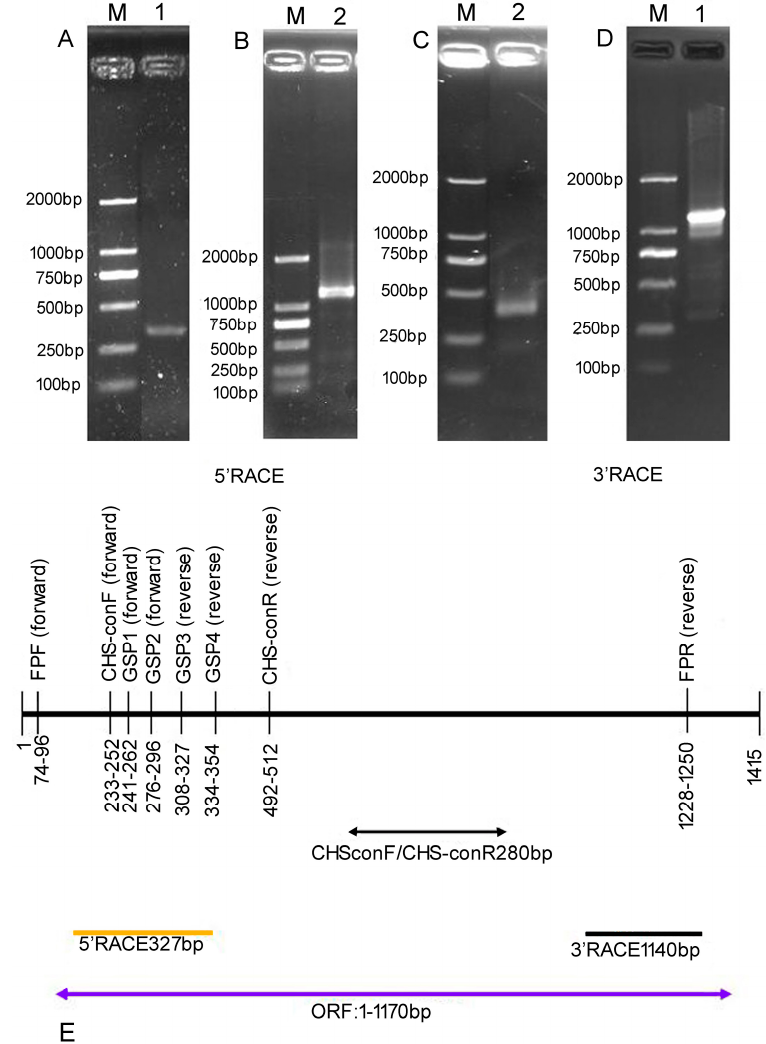
Figure 2. Isolation and identification of BaCHS . ( A ) RT-PCR products from the petals of Brunfelsia acuminata with primers CHS -ConF / CHS -ConR for lane 1. Marker: DL-2000 marker; ( B ) 3 ′ RACE-PCR products from the petals of Brunfelsia acuminata with GSP1/ GSP2 3 ′ RACE-PCR inner primer; ( C ) 5 ′ RACE-PCR products from the petals of Brunfelsia acuminata with GSP3/GSP4 5 ′ RACE-PCR inner primer; ( D ) The full cDNA products of Brunfelsia acuminata petals with FPF/FPR primers; ( E ) RT-PCR and RACE-PCR product lengths with different primers.